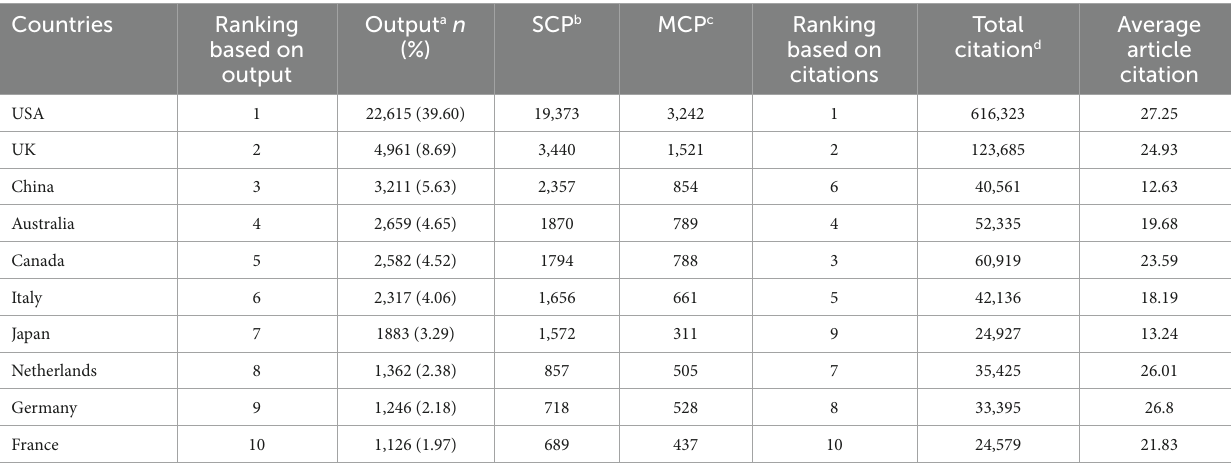
TABLE 1 Publications in top 10 most productive